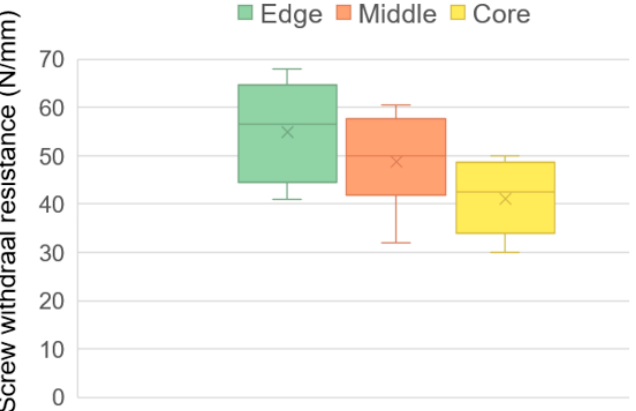
Figure 21. Screw withdrawal resistance of Paulownia samples extracted from the cross-section.